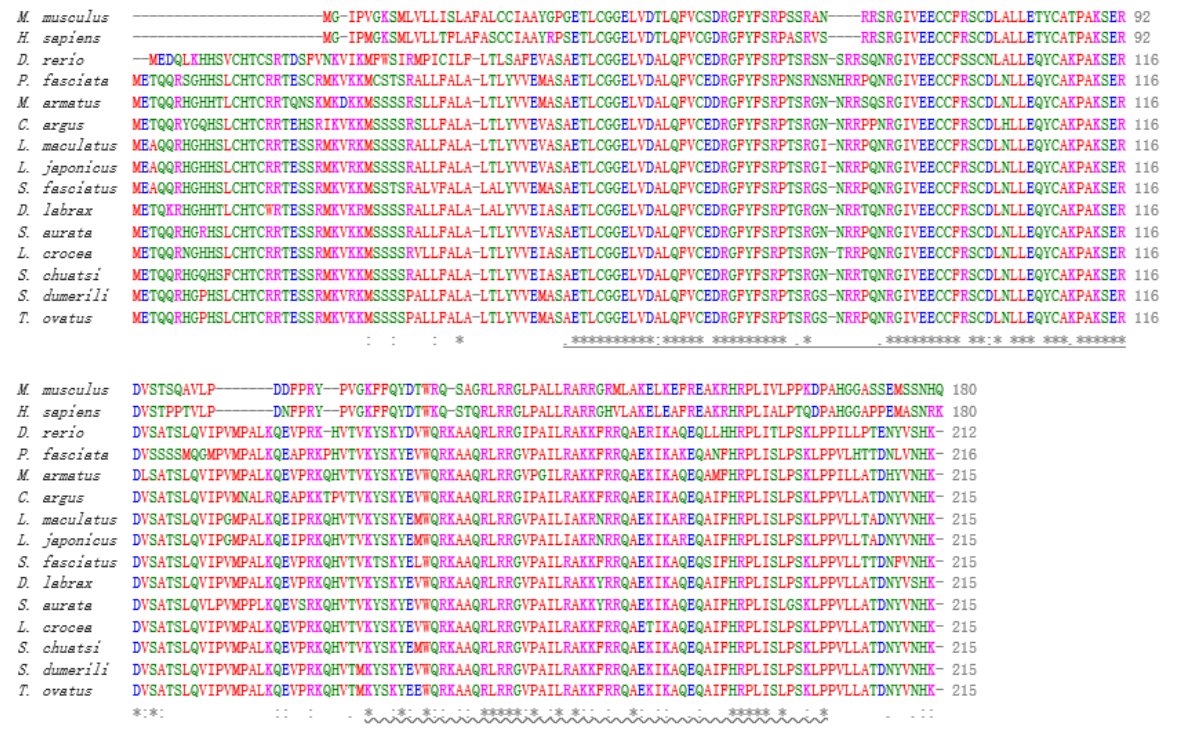
Figure 3. Multiple alignments of IGF2 sequences from various species. The IGF domain is shown with an underline. IGF2_C is represented with a wavy line. Single, strong, or weakly conserved residues are indicated by “*”, “:”, and “.”, respectively. The accession numbers for sequences are shown in Table